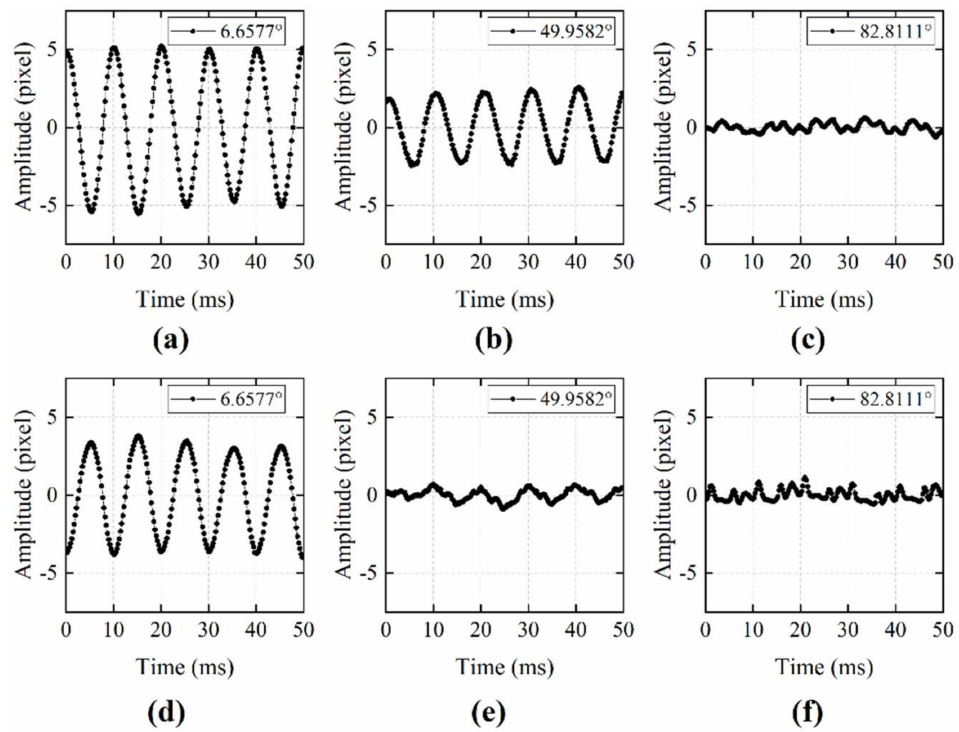
Figure 16. Restored waveform with different 2D image shift angle using different algorithms. ( a – c ) Restored waveform using 1D optical flow algorithm. ( d – f ) Restored waveform using cross- correlation